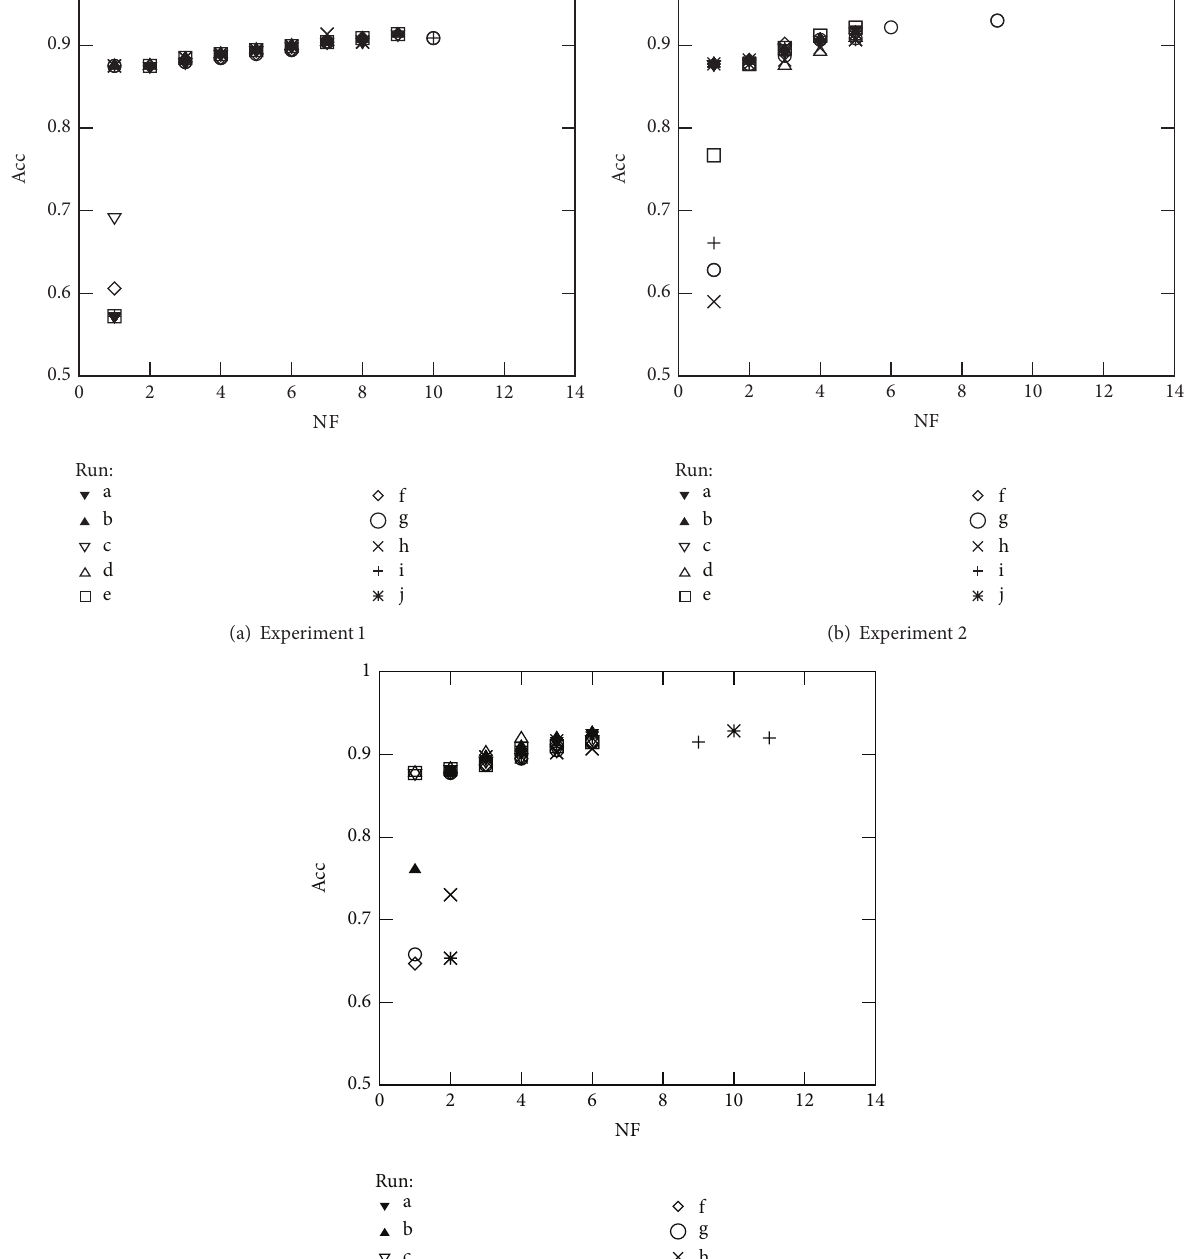
various combinations of features that allow the obtention values. As before, the best solutions of the best 𝑅 and 𝑒 I using five features at the most, NF ≤ 5 , can be selected for each database. Such features are identified in bold in Table 7 and can be used in future classification together with their corresponding classifier